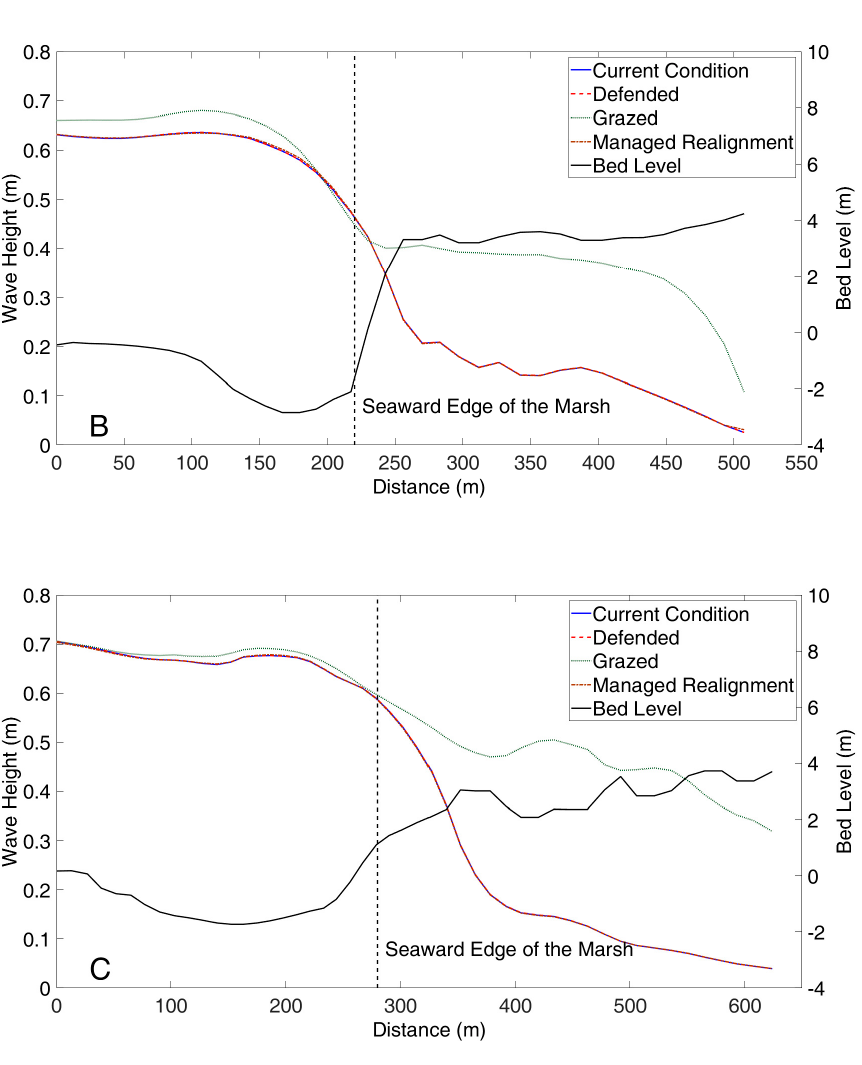
Figure 19. Comparison of peak storm wave height during the 1:50 year easterly storm at T1 ( A ), T2 ( B ), and T3 ( C ). Bed level in m OD. Please note, wave heights for ‘current’, ‘defended’, and ‘managed-realigned’ cases overlap with each other. Right hand side is the landward boundary.